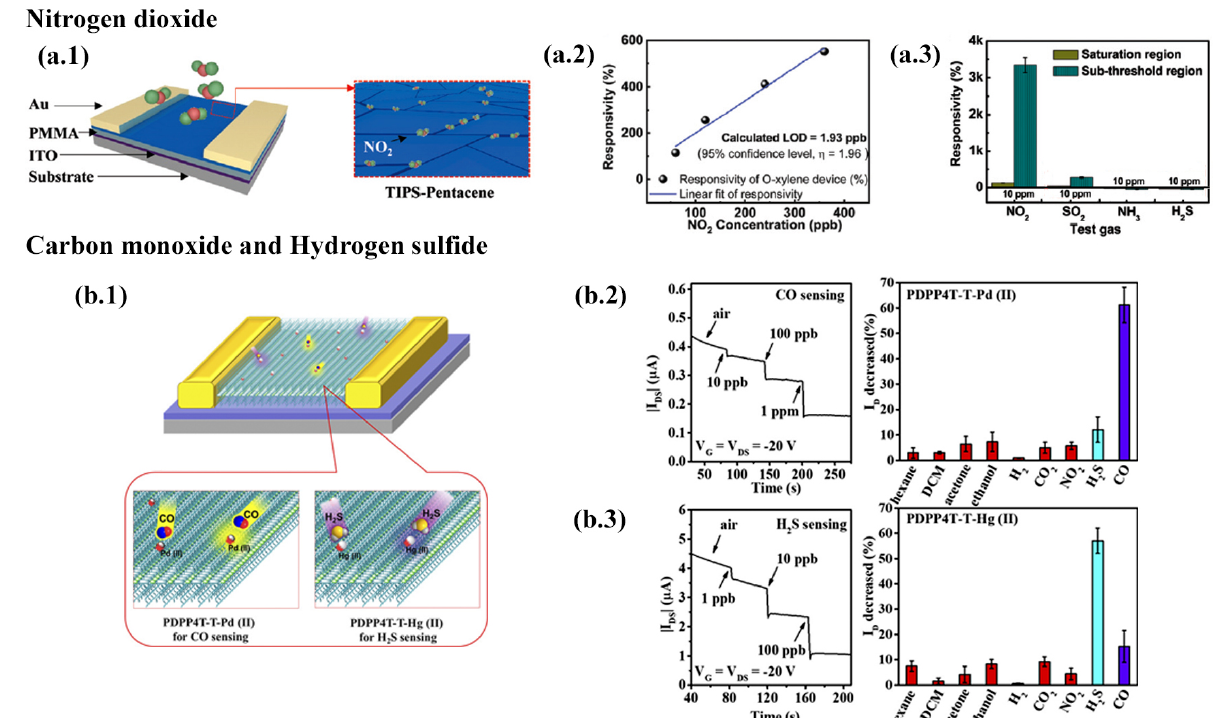
Figure 10. High-sensitivity gas sensors for nitrogen dioxide, carbon monoxide and hydrogen sulfide detection: ( a.1 ) Schematic diagram of the TIPS-pentacene TFT-based NO 2 sensor from an o-xylene solution. Illustration of the gas sensing mechanism. ( a.2 ) Plot for the limit of detection ( LoD ) calculation. ( a.3 ) Sensor response in the saturation and subthreshold regions towards 10 ppm of NO 2 , SO 2 , NH 3 and H 2 S. Republished from reference [96] with permission from The Royal Society of Chemistry. ( b.1 ) Schematic diagrams of PDPP4T-T-based TFTs for CO and H 2 S sensing. ( b.2 ) PDPP4T-T-Pd(II)-based TFTs. Left graph: Current response to CO with concentrations ranging from 10 ppb to 1 ppm. Right graph: Sensor performance towards hexane (52,000 ppm), dichloromethane (DCM) (301,000 ppm), acetone (1000 ppm), ethanol (1200 ppm), H 2 (pure), CO 2 (pure), NO 2 (100 ppm), H 2 S (100 ppm) and CO (1 ppm). ( b.3 ) PDPP4T-T-Hg(II)-based TFTs. Left graph: Current response to H 2 S with concentrations ranging from 1 to 100 ppb. Right graph: Sensor performance towards hexane (52,000 ppm), DCM (301,000 ppm), acetone (1000 ppm), ethanol (1200 ppm), H 2 (pure), CO 2 (pure), NO 2 (100 ppm), H 2 S (1 ppm) and CO (100 ppm). Reprinted with permission from reference [93]. Copyright (2019) American Chemical